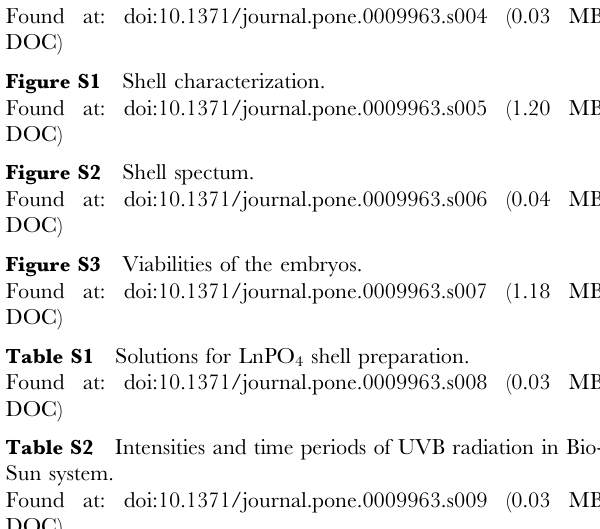
Table S2 Intensities and time periods of UVB radiation in Bio- Sun